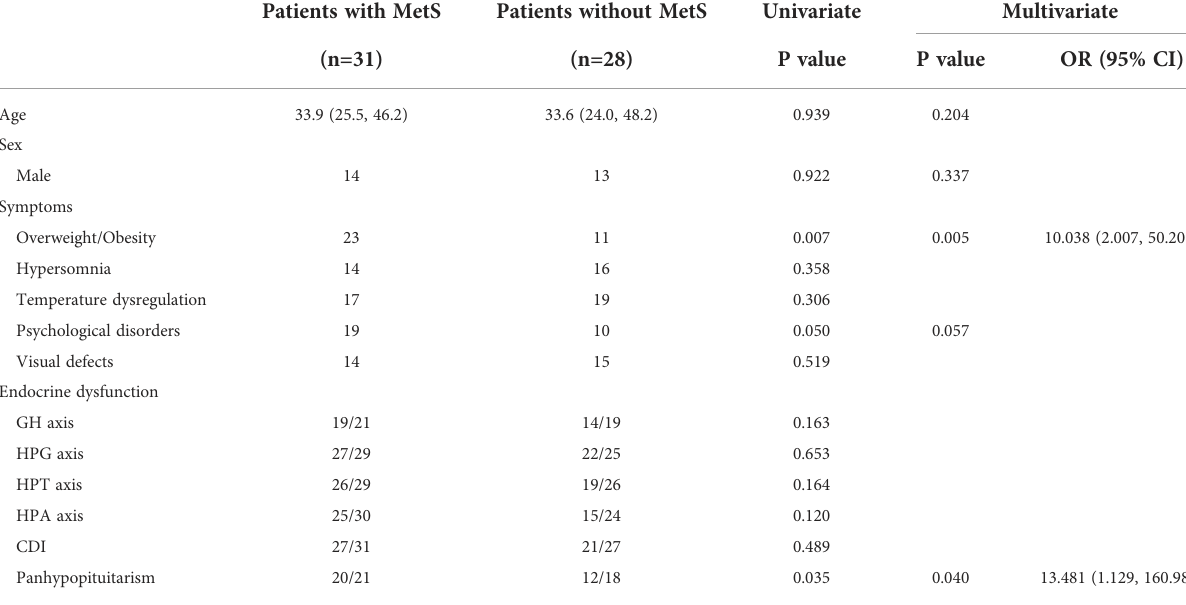
TABLE 5 Univariate and multivariate predictors of metabolic syndrome in adults with hypothalamic dysfunction. Patients with